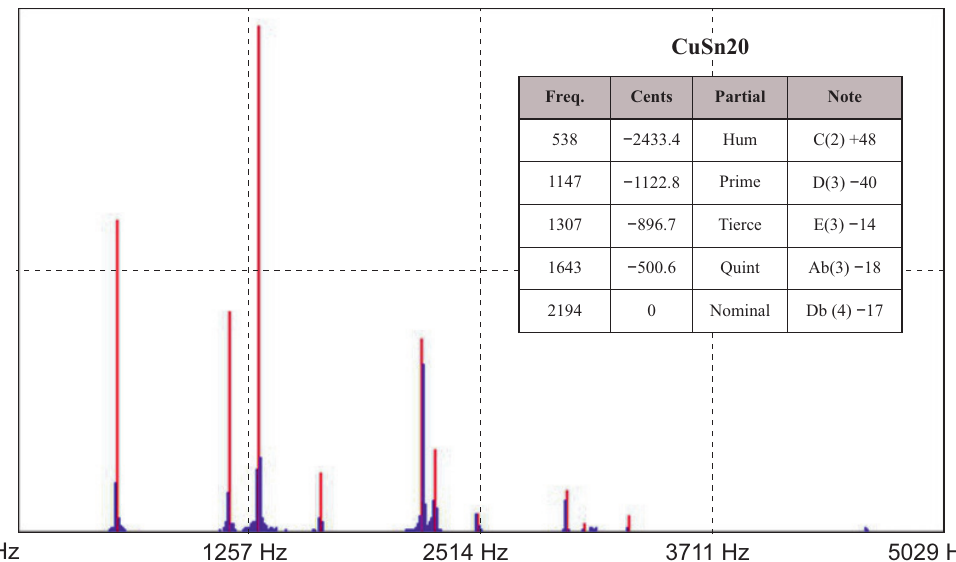
Figure 11. Results from the Wavanal program—bell bronze.